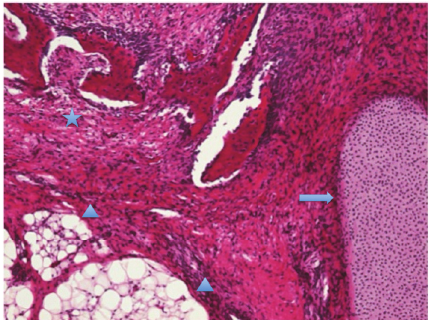
Figure 5: Histological section showing the immature teratoma with immature tissue of the bone (asterisk), cartilage (arrow), and islands of adipose tissue (arrowhead) (hematoxylin and eosin, 100x